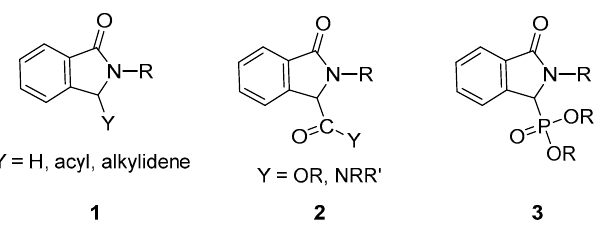
Figure 1. General formula of isoindolin-1-one derivatives ( 1 ), isoindolin-1-one carboxylates ( 2 ) and isoindolin-1-one phosphonates ( 3 ).